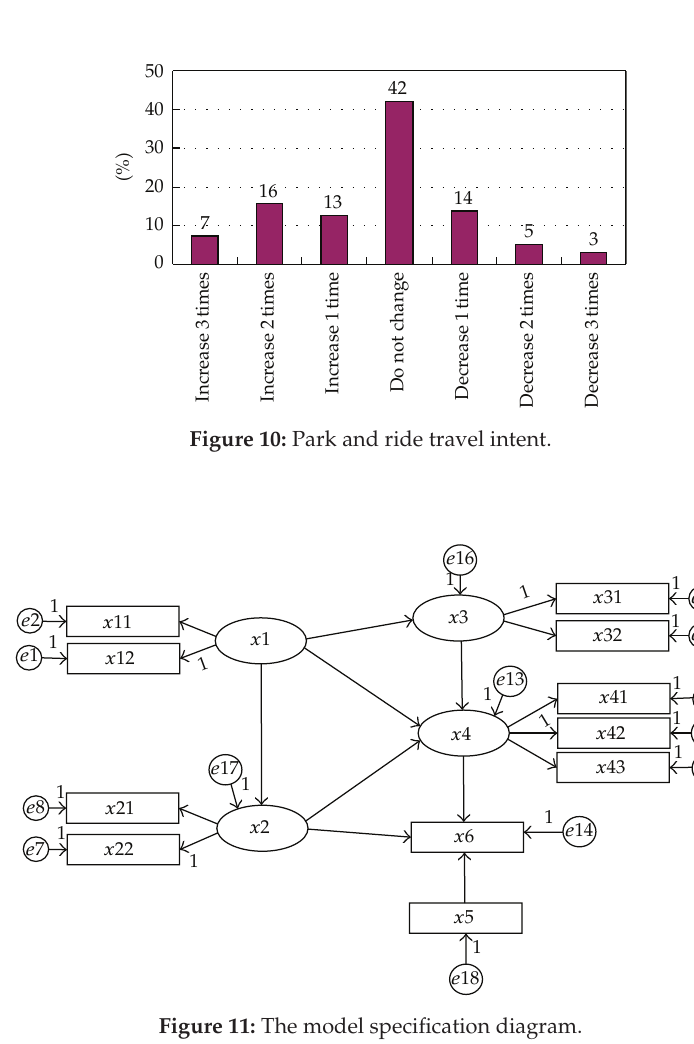
Figure 11: The model specification